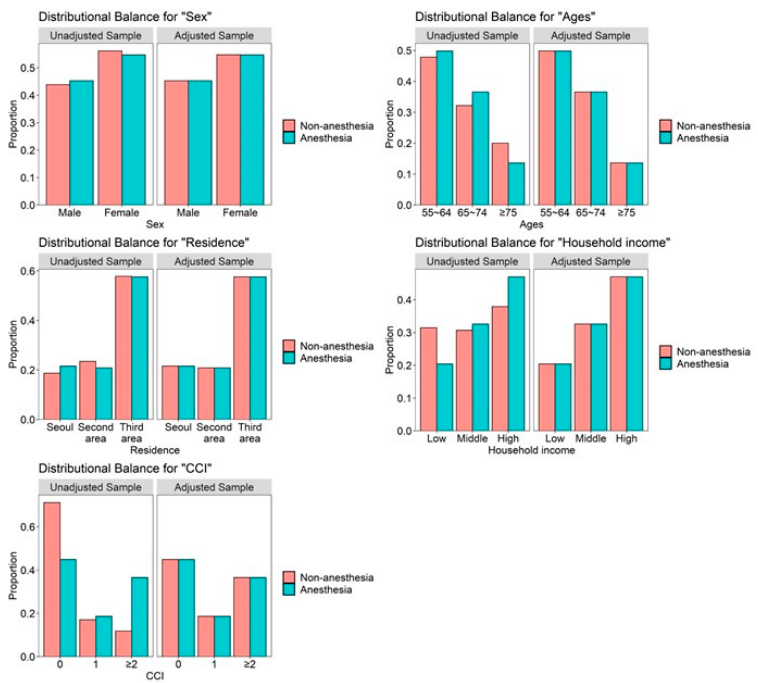
Figure A1. Balance plot for key variables before and after matching. Table A2. List of Charlson’s comorbidities and weights.